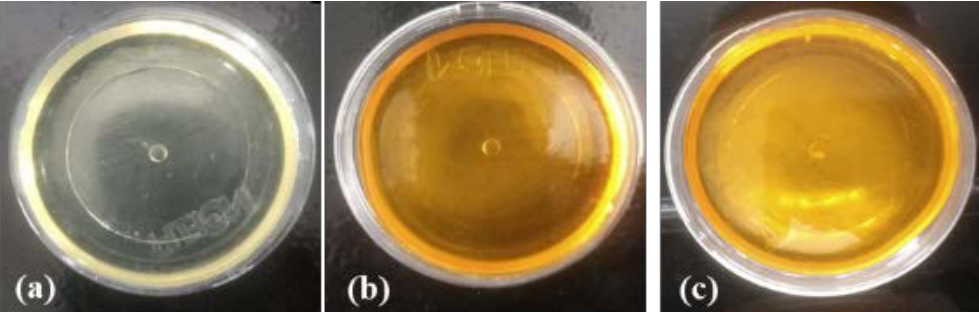
Figure 2. Pure ureasil-polyether (U-PEO 500) hybrid material ( a ) with curcumin ( b ) and curcumin-micelle 3% ( c ).